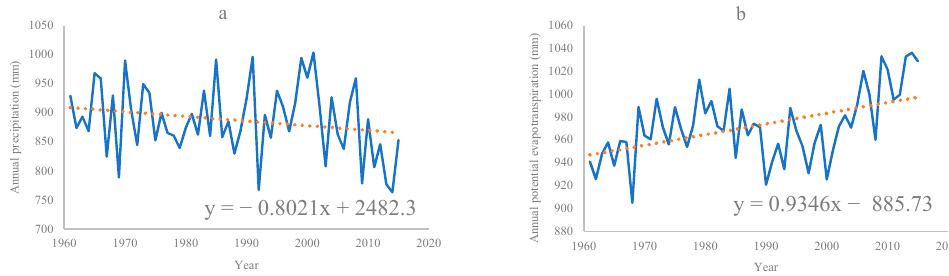
Figure 2. Interannual variation trend of precipitation ( P ) ( a ) and potential evapotranspiration ( E 0 ) ( b ) in the Lancang River Basin (LRB) from 1961 to 2015.